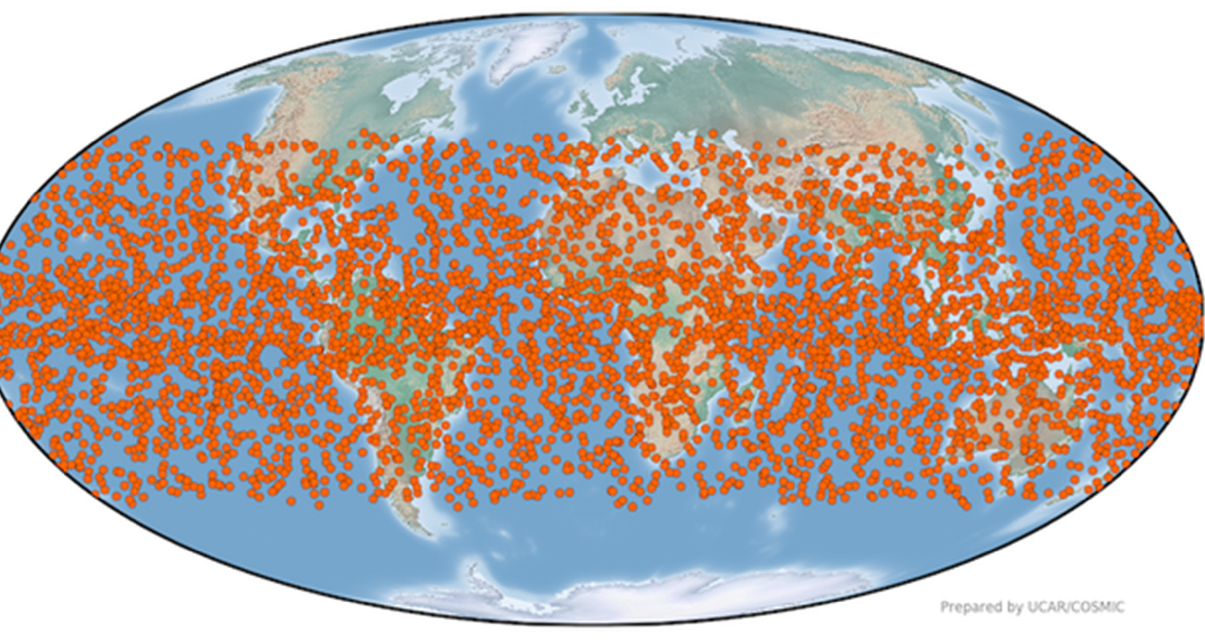
Figure 2. GPS occultation data probe points on 1 October 2019. Provided by COSMIC-2 (NOAA/NESDIS) (noaa.gov).